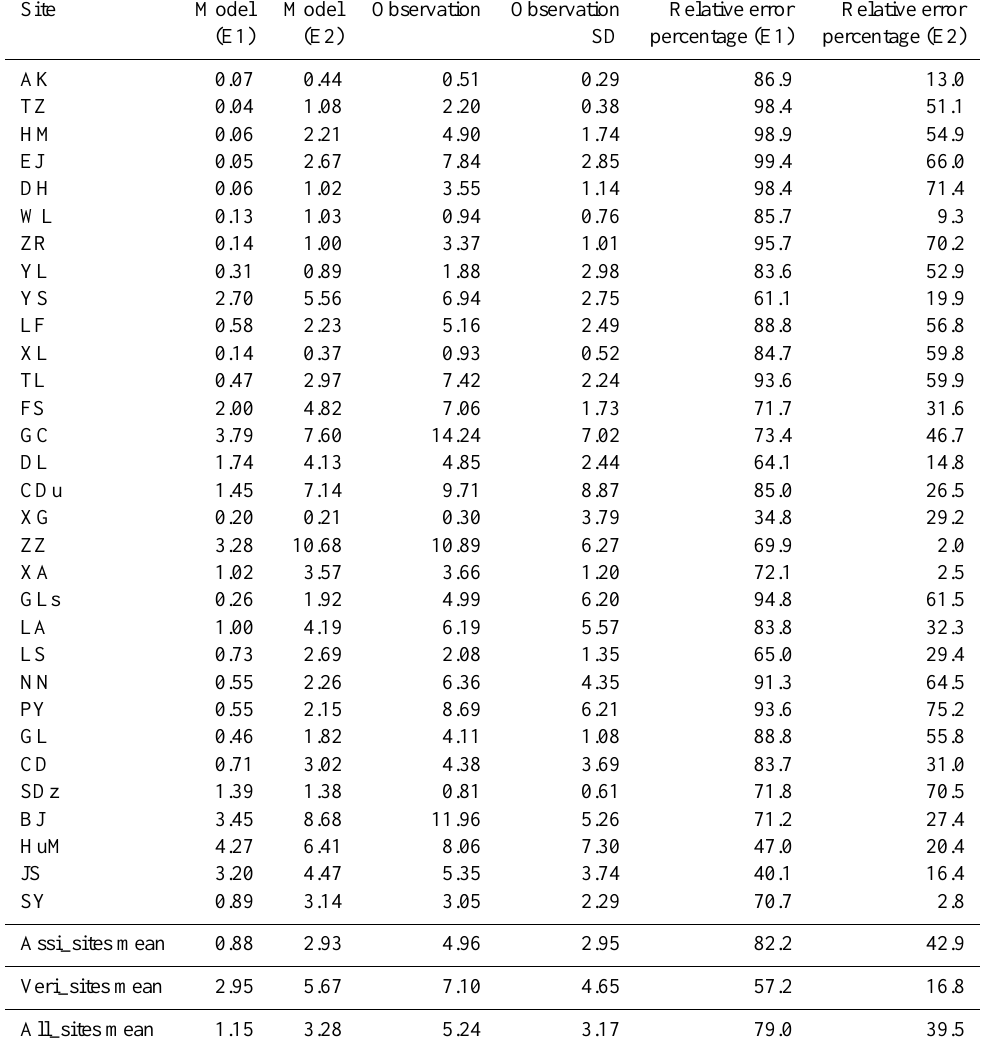
Table 3. Model simulations and surface observations of monthly mean BC concentrations at assimilation sites and verification sites